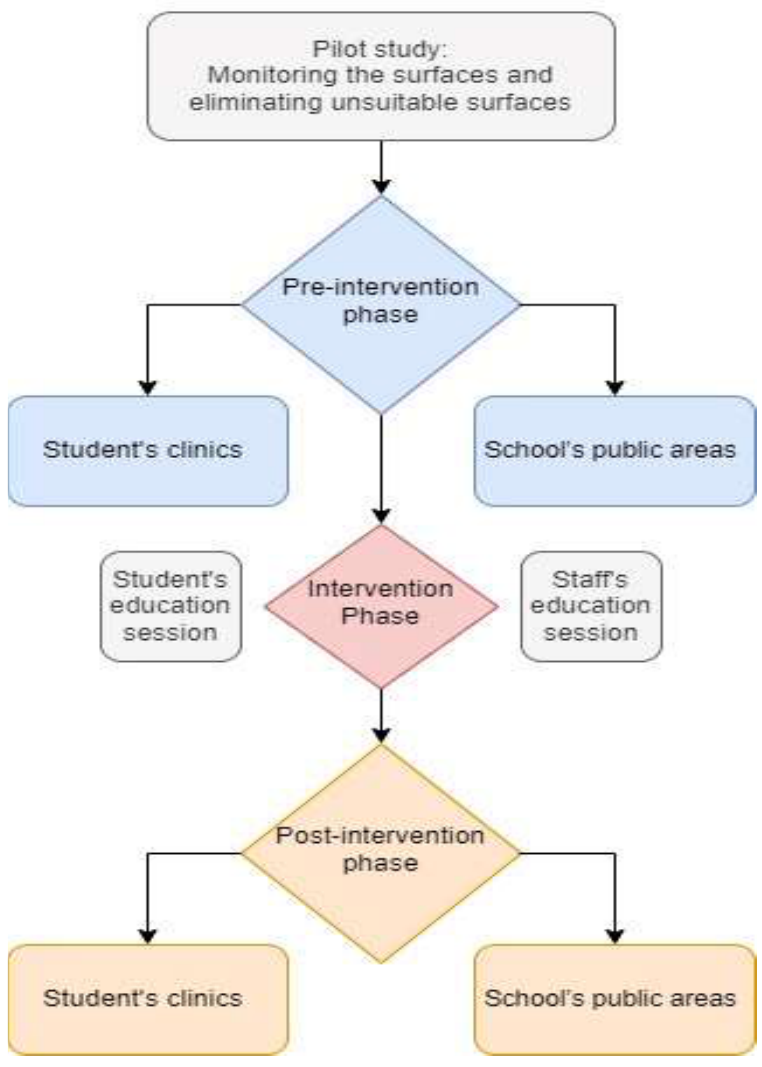
Figure 1. Study design flowchart.